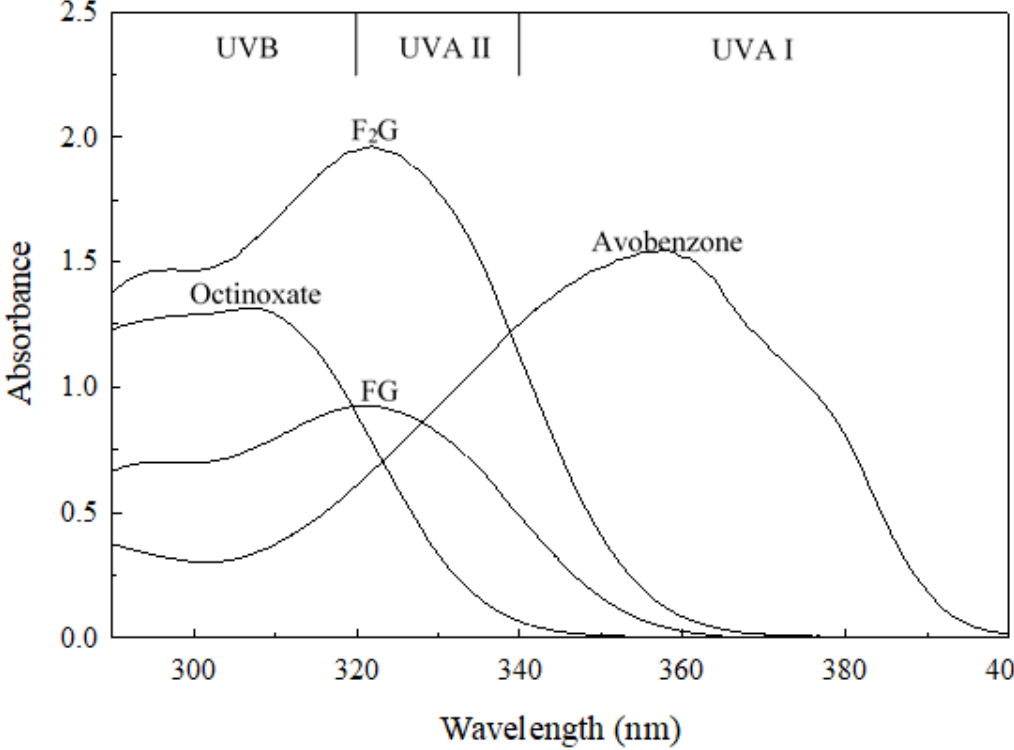
Figure 4. UV absorption spectra of F 2 G and FG in comparison to the commercial UV-absorbing ingredients Octinoxate and Avobenzone (50 μM solutions in acetonitrile). UVB, UVA II, and UVA I